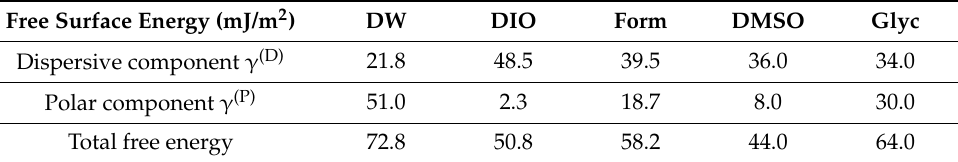
Table 2. Dispersive and polar components of the free surface energy for the 5 fluids used in our experiments. The total free energy is the sum of both components. DW = distilled water/DIO = Di- iodomethane/Form = Formamide/DMSO = Dimethyl Sulfoxide/Glyc = Glycerol.